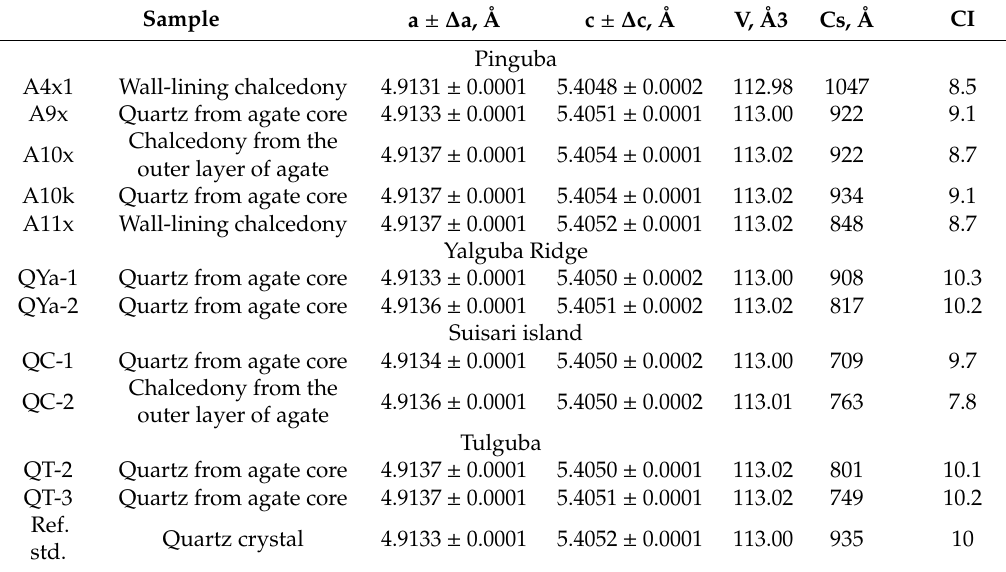
Table 3. Unit cell parameters of quartz and chalcedony from Onega